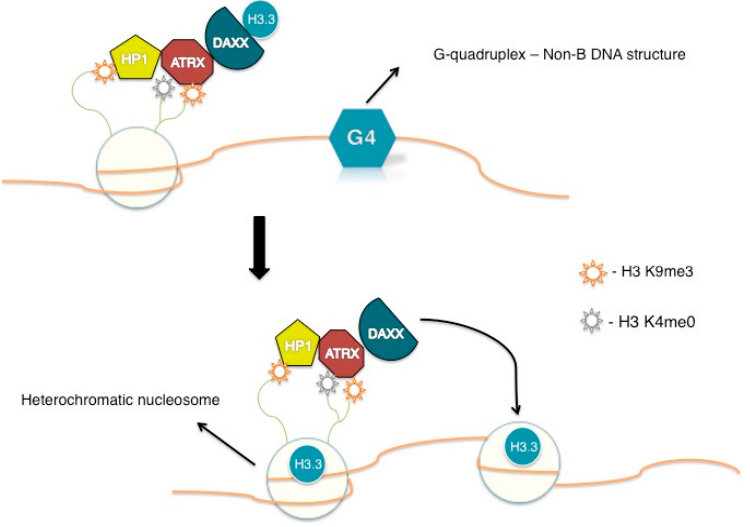
Figure 2. A proposed theoretical mechanism for Alpha Thalassemia/Mental Retardation Syndrome X ‐ Linked/Death ‐ Domain Associated Protein (ATRX/DAXX) chromatin landscaping: ATRX binds to histone H3 at heterochromatin through interaction of its ATRX ‐ DNMT3 ‐ DNMT3L (ADD) domain with an H3 N ‐ terminal tail, trimethylated at Lys9 (H3K9me3) and unmodified at Lys4 (H3K4me0). HP1 also recognizes H3K9me3, boosting this recruitment. Once in its target site, ATRX, in